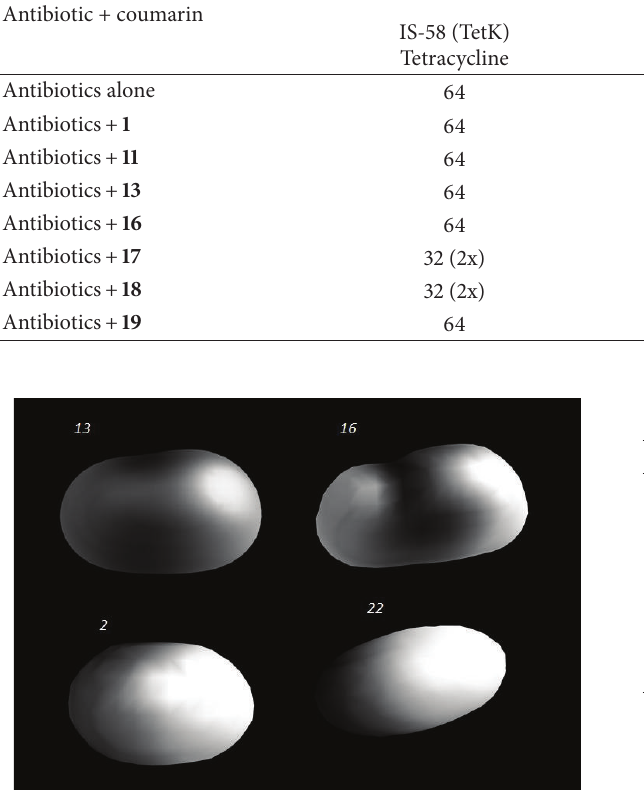
Figure 1: Representation of the PSA (Polar Surface Area) of active ( 13 and 16 ) and inactive ( 2 and 22 ) compounds using VEJA ZZ program. White represents polar surface and grey-dark represents no-polar surfaces.